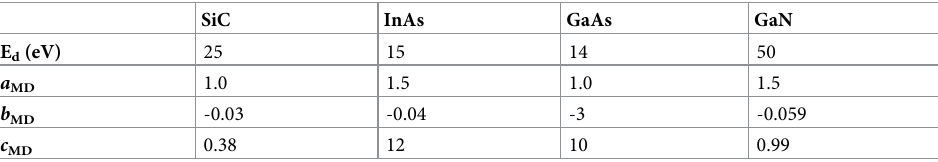
Table 1. Material constants used for the calculation of damage production. E d values for SiC [16], GaAs [17], GaN [18] and InAs [19] were obtained from the